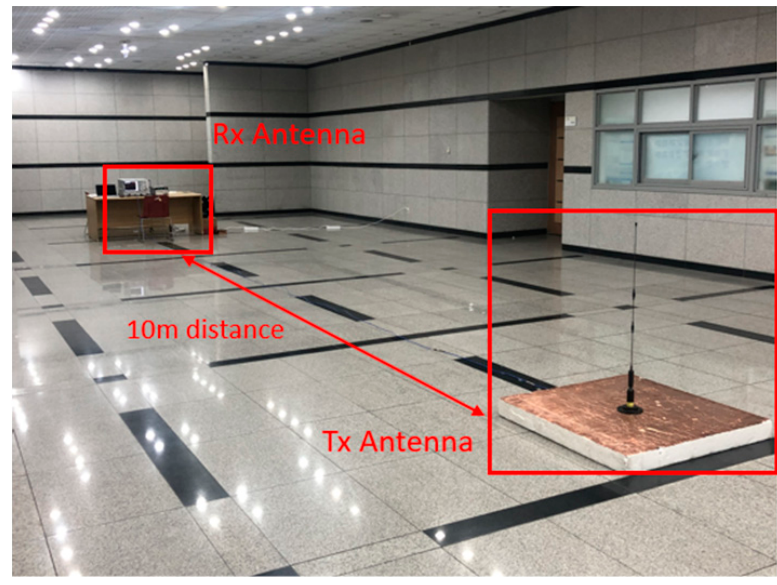
Figure 15. Received power measurement environment.